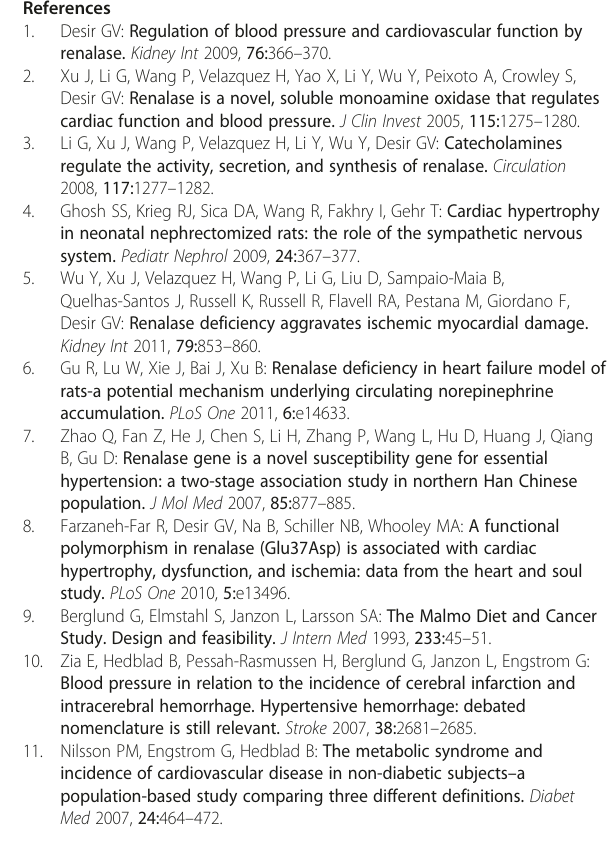
Table S3. Beta coefficient and SE for interaction terms (either sex or age) with RNLS rs2576178 and rs2296545 polymorphisms and BP-related traits according to different mode of inheritance. Table S4. Association between the RNLS rs2296545 polymorphism and BP according to different genetic model in subjects with impaired kidney